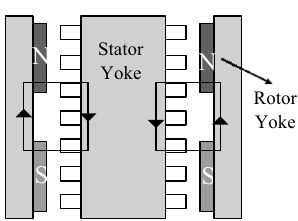
Figure 7 Magnetic circuit of an NN-type torus-NS motor